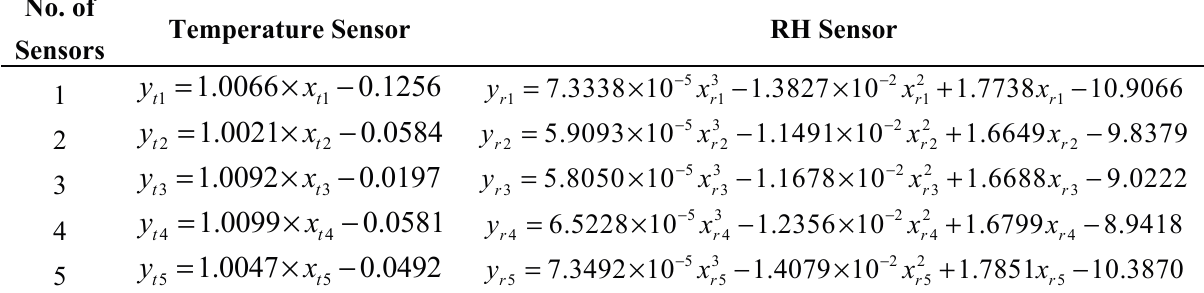
Table 2. Calibration equation of five RH/Temperature